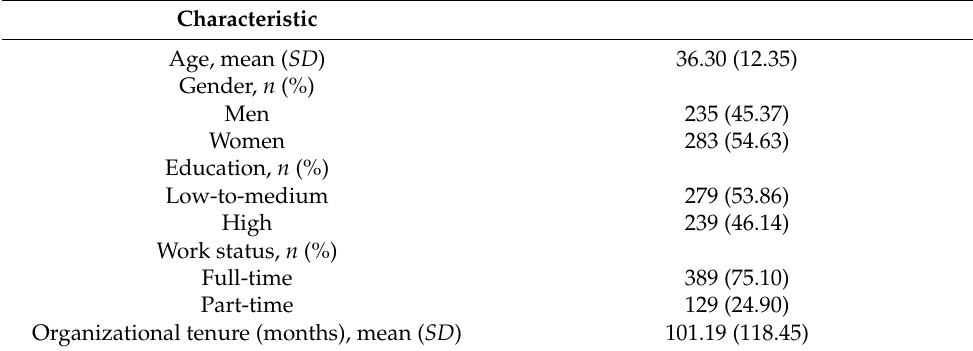
Table 1. Participants’ characteristics ( N =